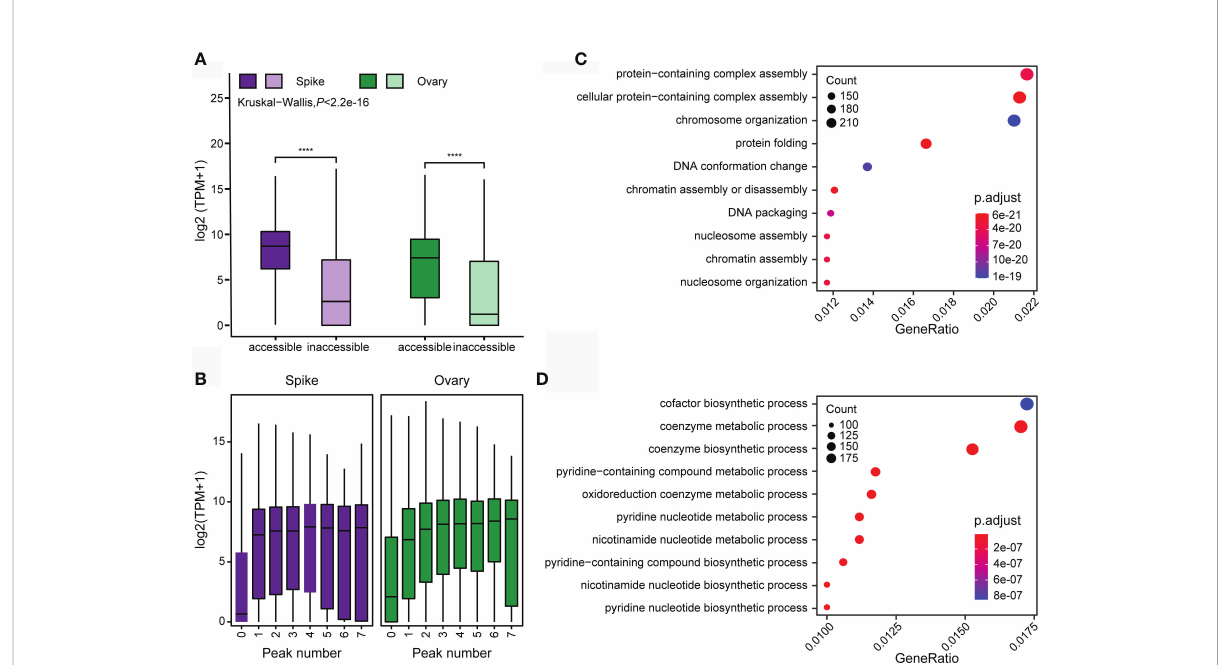
FIGURE 6 Correlation between chromatin accessibility and gene transcription in young spike and ovary. (A) Differences in gene transcription level between the genes with and without open chromatin. **** indicates P < 0.0001. (B) Correlation between gene transcription level and the number of ATAC-seq peaks. GO enrichment analysis of chromatin accessibility-related genes in young spike (C) and ovary (D)